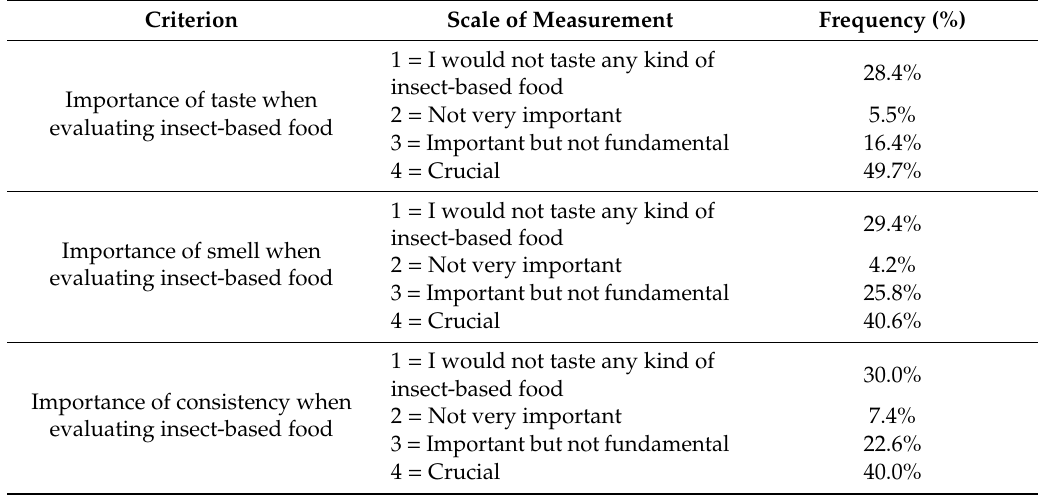
Table 4. Sample statistics about the importance of organoleptic features of insect-based